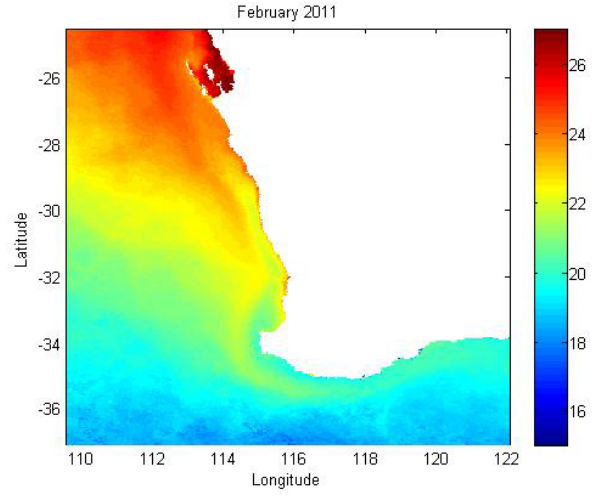
Fig. 1. Mean SST for February 2011 along the southwest Australian coastline. SSTs generated from NASA’s MODIS Aqua 4km dataset, scalebar indicates SSTs in ◦ C.